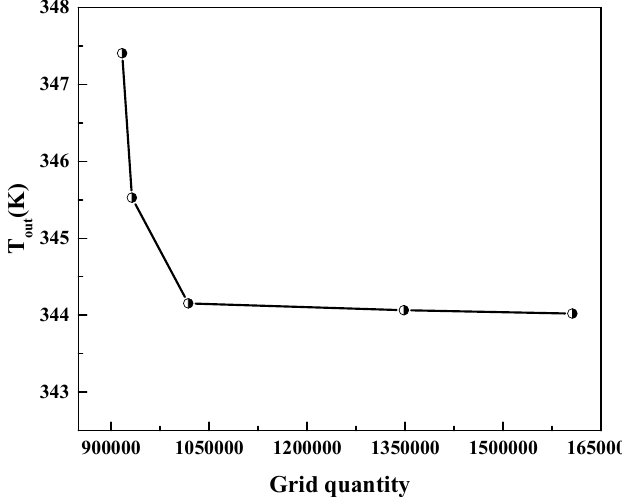
Figure 5. Relationship of average outlet temperature with grid quantity.